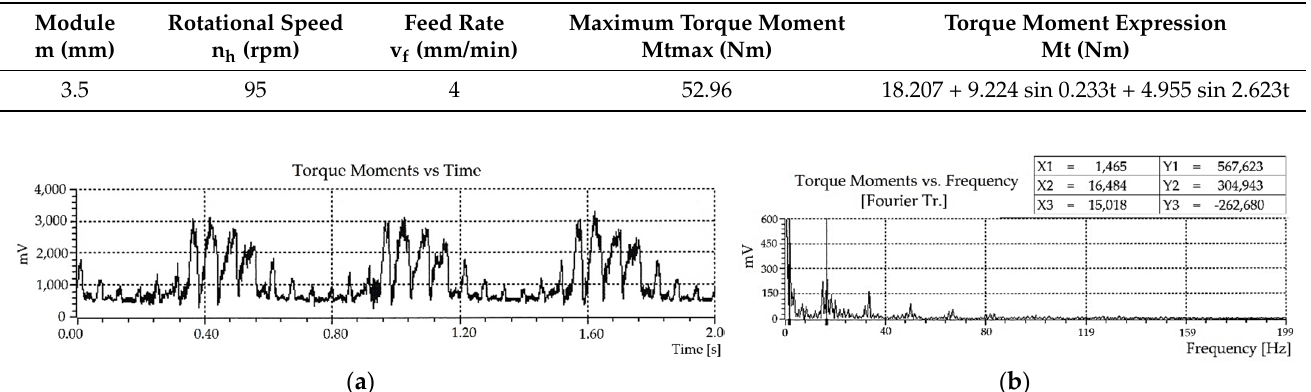
Figure 4. Graphs for the torque moment variation: ( a ) torque moment vs. time; ( b ) torque moment vs. frequency.